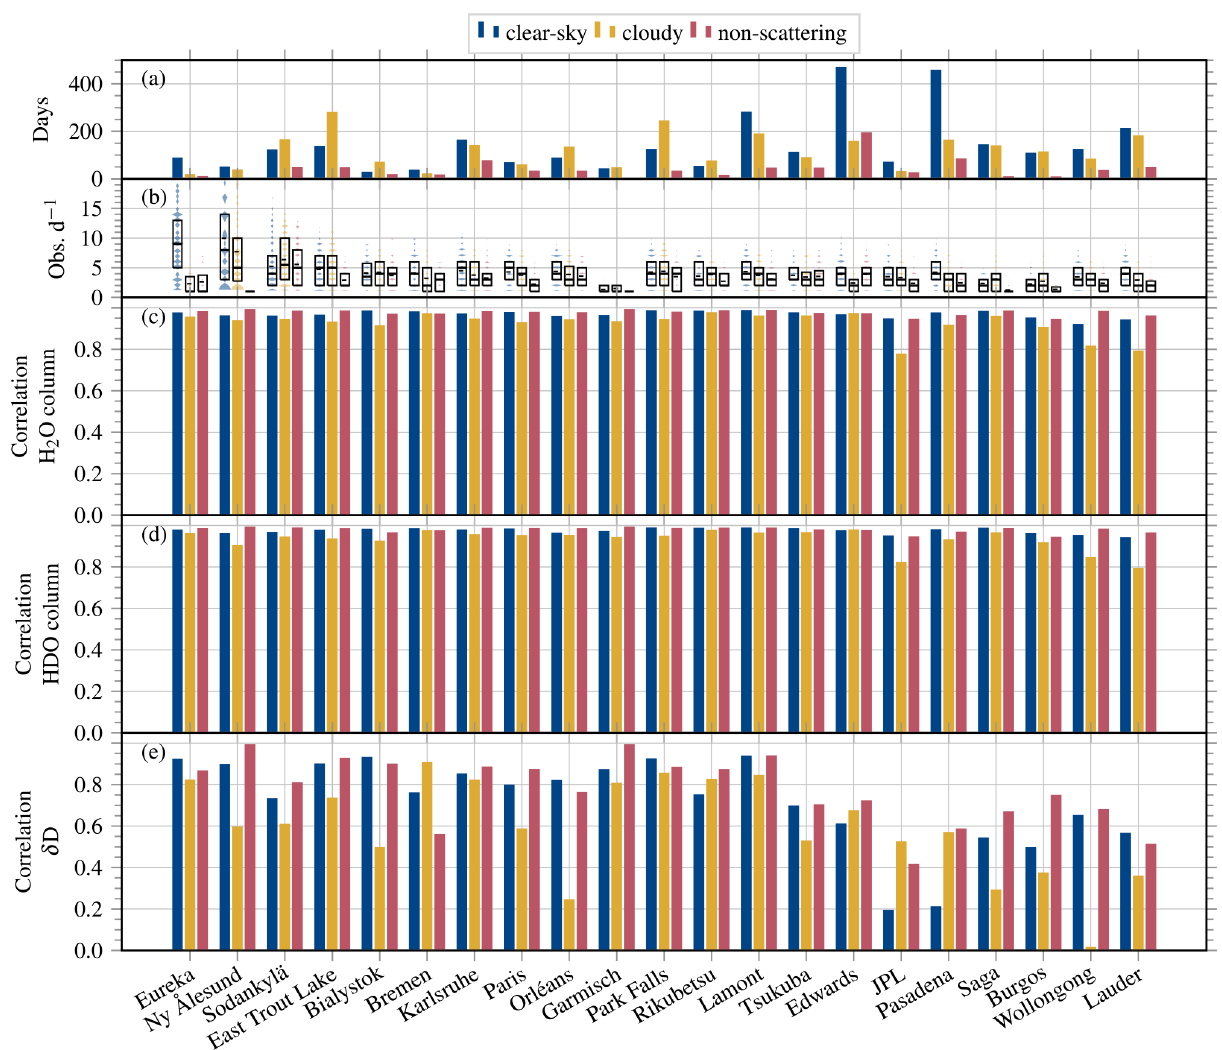
Figure 8. (a) Number of days with observations, (b) observations per day, (c) correlation coefficients of H 2 O columns, (d) correlation coefficients of HDO columns and (e) correlation coefficients of a posteriori δ D at all TCCON